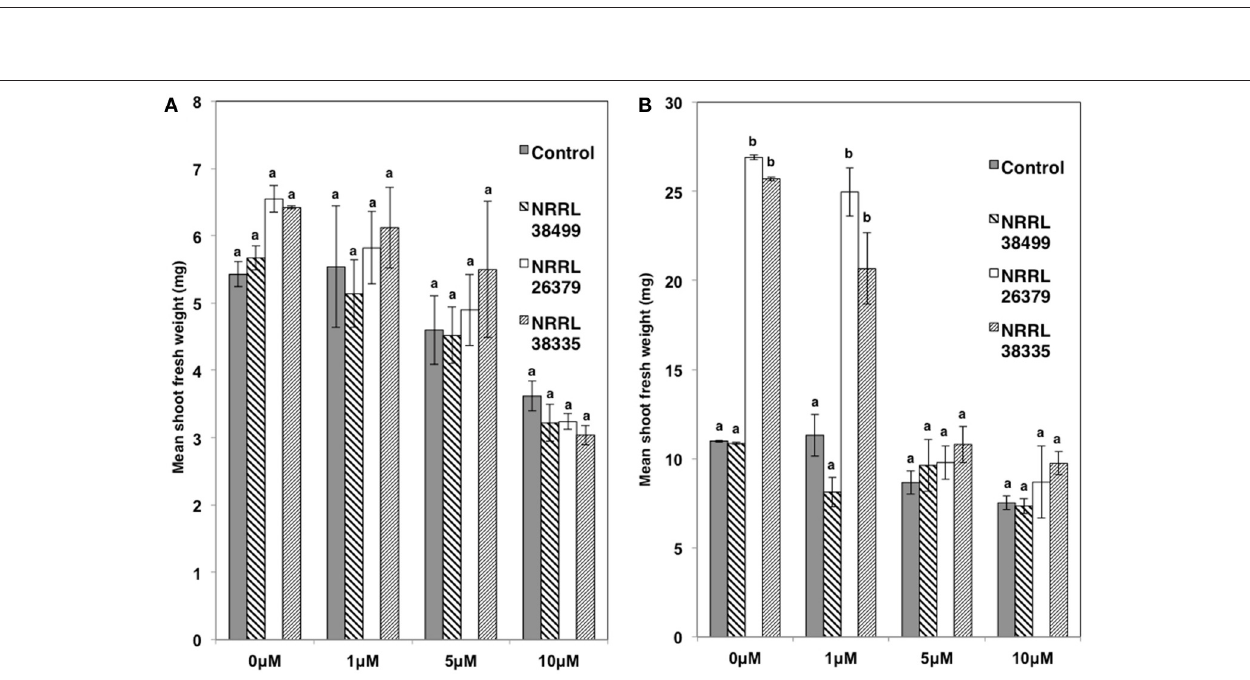
FIGURE 9 | Effect of NPA on volatile-mediated growth enhancement. The shoot fresh weight of Col-0 containing DR5::GUS was measured after cocultivation with no fungus (control), NRRL 38499, NRRL 26379, and NRRL 38335 for 7 (A) and 14 (B) days in the presence of NPA. Means and standard errors for three biological replicates per treatment, with five seedlings per replicate, are shown. Different letters on columns denote statistically significant differences within each NPA treatment by one-way analysis of variance.